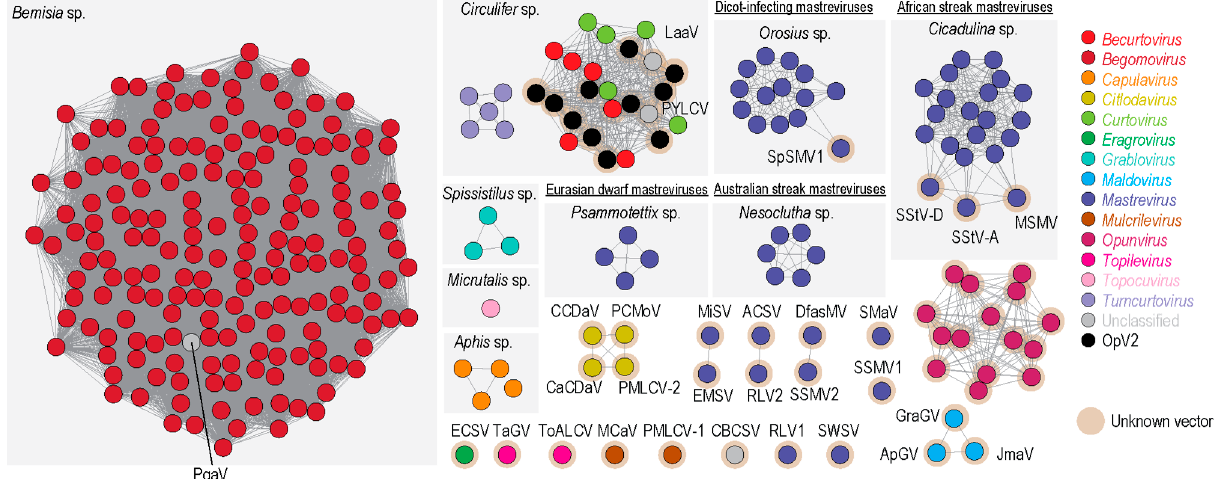
Figure 8. Sequence similarity network analysis of the CP amino acid sequences of geminiviruses present in GenBank (dataset was created with an amino acid identity cut-off of 90%), together with representatives of the 11 genotypes from OpV2, 15 genotypes from OpV1, and one Opuntia becurtovirus. Each dot represents a sequence and is colored based on the genus or group. The genera that have known insect vectors are highlighted in a light grey box with the insect vector name displayed at the top. Clusters or singletons marked with a brown halo have no known insect vector associated with them. ApGV, apple geminivirus; ACSV, Axonopus compressus streak virus; CaCDaV, Camellia chlorotic dwarf-associated virus; CCDaV, citrus chlorotic dwarf-associated virus; DfasMV, dragonfly-associated mastrevirus; CBCSV, common bean curly stunt virus; ECSV, Eragrostis curvula streak virus; EMSV, Eragrostis minor streak virus; GraGV, grapevine geminivirus; JmaV, Juncus maritimus -associated virus; LaaV, Limeum africanum -associated virus; MCaV, mulberry crinkle- associated virus; MiSV, Miscanthus streak virus; MSMV, maize streak Reunion virus; PYLCV, parsley yellow leaf curl virus; PMLCV-1, paper mulberry leaf curl virus 1; PMLCV-1, paper mulberry leaf curl virus 2; PCMoV, passion fruit chlorotic mottle virus; PgaV, Polygala garcinii -associated virus; RLV1, rice latent virus 1; RLV2, rice latent virus 2; SMaV, switchgrass mosaic-associated virus; SpSMV1, sweet potato symptomless mastrevirus 1; SSMV1, Sporobolus striate mosaic virus 1; SSMV2, Sporobolus striate mosaic virus 2; SStV-A, sugarcane striate virus A; SStV-D, sugarcane striate virus D; SWSV, sugarcane white streak virus; TaGV, tomato-associated geminivirus; ToALCV, tomato apical leaf curl virus.